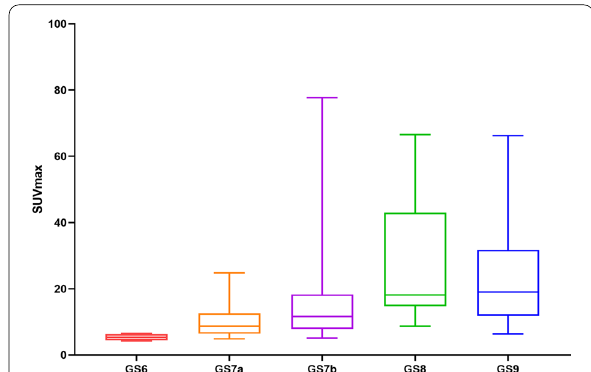
Fig. 4 Comparison of 18 F‑PSMA‑1007 uptake expressed in SUVmax value in primary tumors of different GS subgroups. Box plots demonstrate that higher GS exhibited statistically significant higher tracer uptake in the primary tumor